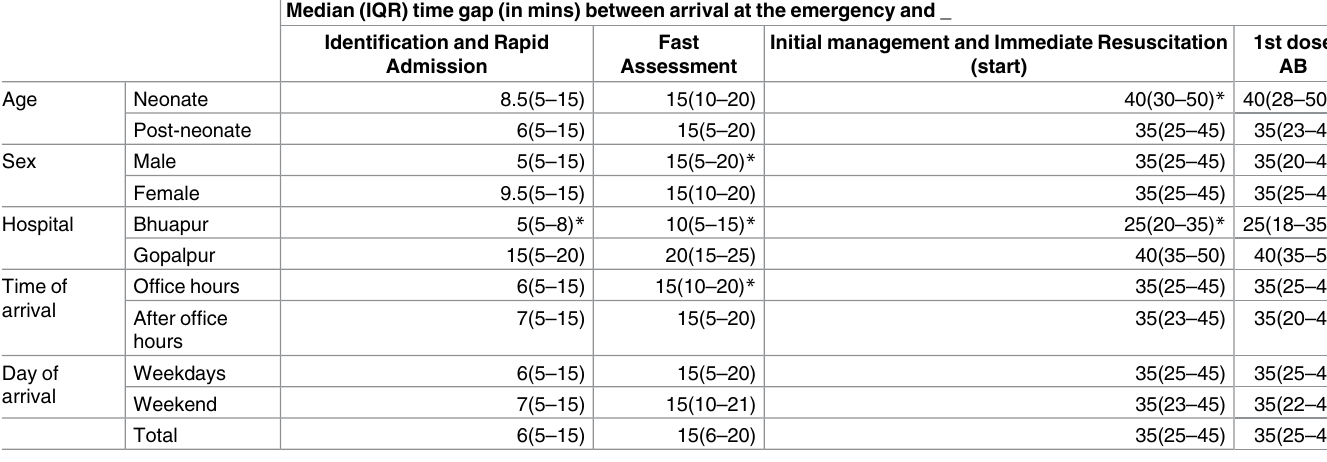
Table 3. Time gaps between arriving in the emergency department and conduction of different steps of management of syndromic sepsis.